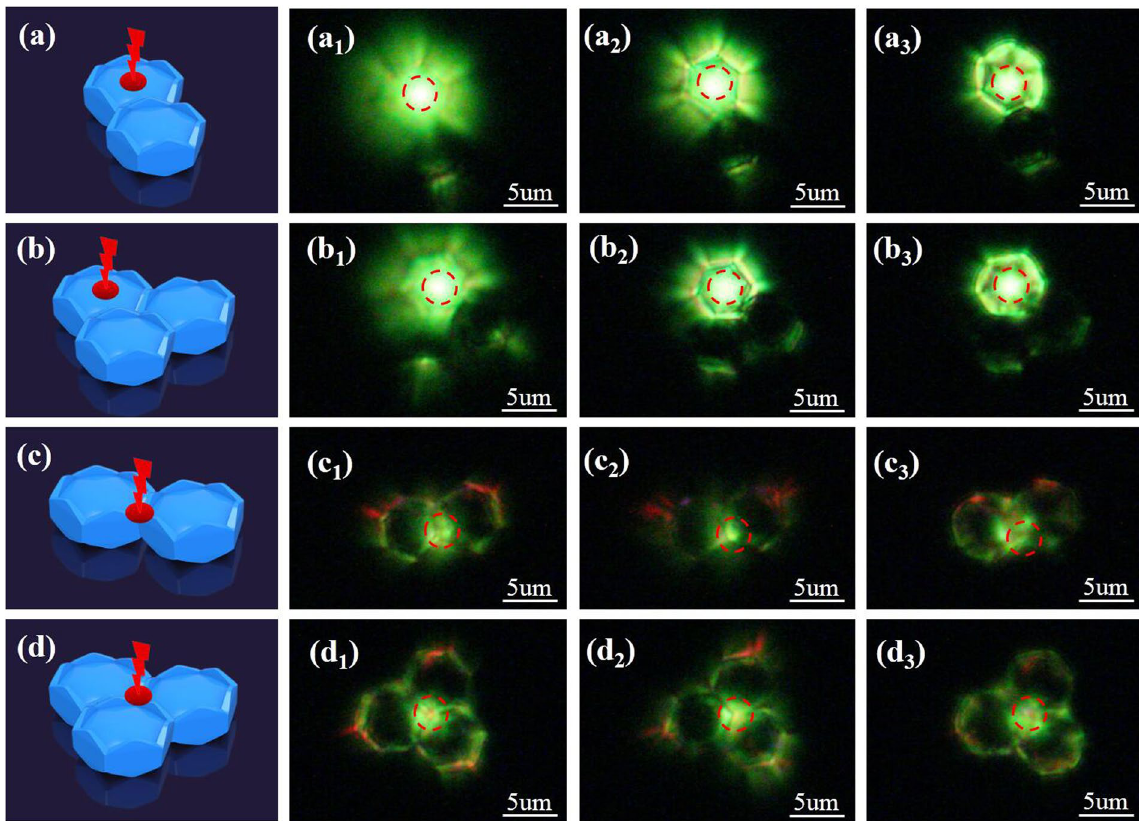
Figure 5. Sample illustration and photographs of UC luminescence from closely situated PS β HMs. ( a ), ( b ), ( c ) and ( d ) are schematic illustration of the sample configuration and the position of the excitation light. (a 1–3 ) and (c 1–3 ) are emissions of dimer microcrystals that are excited at the center and the corner of one particle from the top to the middle surface, respectively. (b 1–3 ) and (d 1–3 ) are emissions of trimer microcrystals that are excited at the center and the corner of three neighbored hexagonal microcrystals from the top to the middle surface, respectively. Red dash-line circles indicate the specific position of the excitation light in the experimental